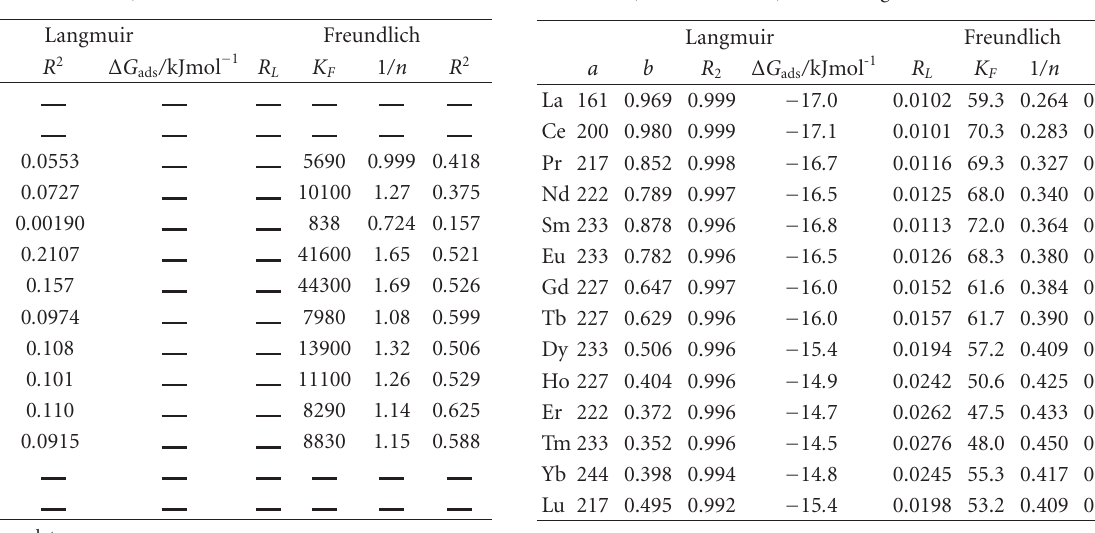
Table 5: Coe ffi cient of Langmuir and Freundlich isotherms for lanthanides using Buccinum tenuissimum shell biomass after heat treatment (950 ◦ C , 6 hours).